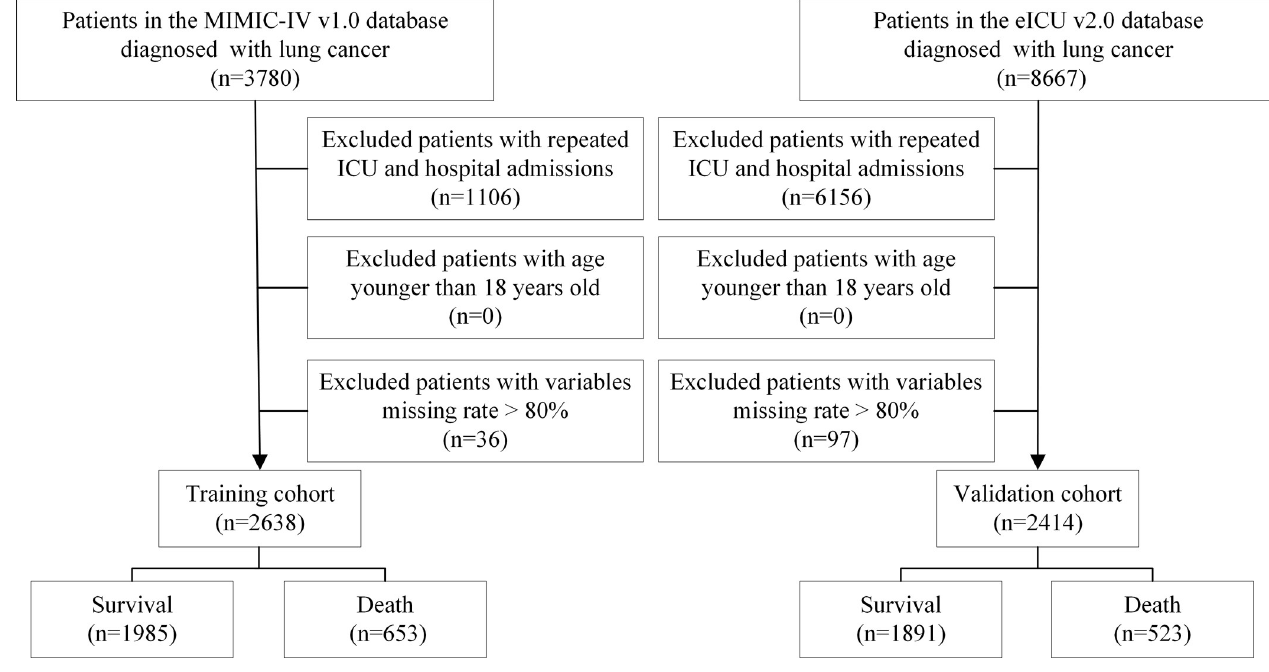
Fig 1. The flow chart of this